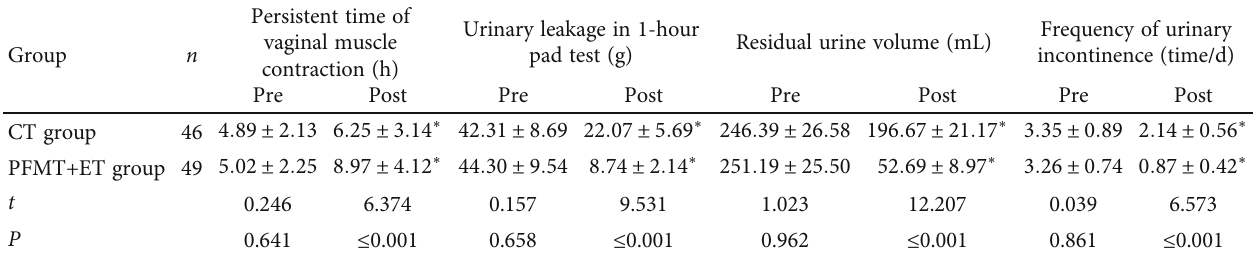
Table 4: Comparison of the degree of pelvic fl oor muscle dysfunction between the two groups after the intervention. Group